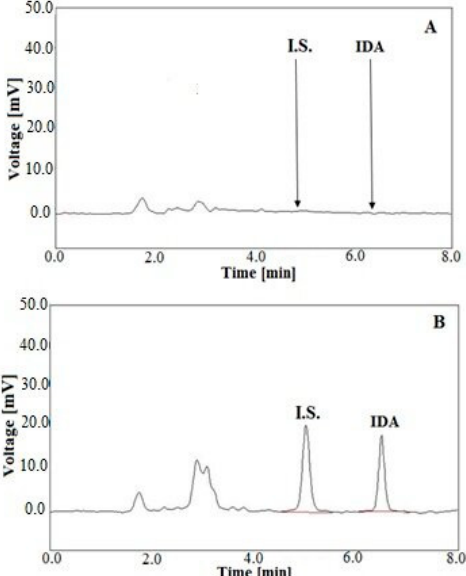
Figure 4. Representative LC chromatograms of blank human urine extracts ( A ), and a urine sample spiked with IDA at the level of 100 ng / mL and DAU (I.S.) at a concentration of 100 ng / mL ( B ), after SPE with HLB cartridges.